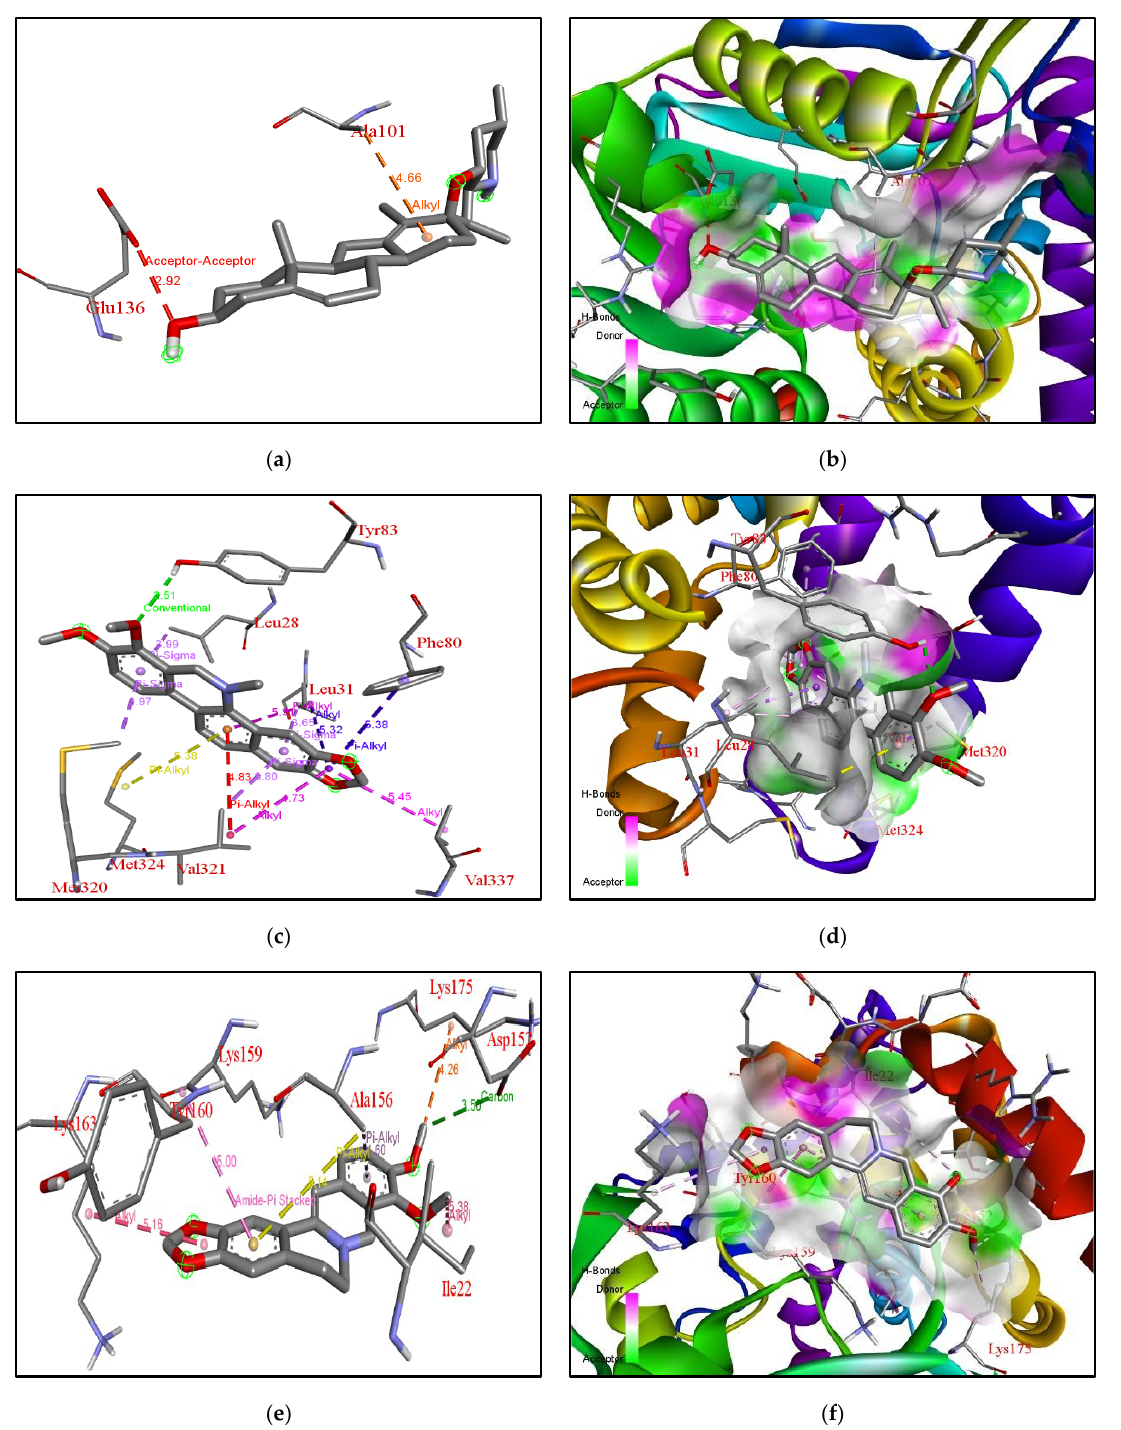
Figure 6. Analysis of docking pocket of ERG6: Interactions, bond lengths and hydrogen bond donor and acceptor around ligand binding pocket for yeast ERG6-ligand interaction are shown in these figures. ( a ) ERG6-cyclopamine acceptor-acceptor interactions in red, alkyl interactions in orange, red. ( b ) ERG6 surface at proximity to cyclopamine. ( c ) ERG6-chelerythrine interactions in red, yellow, magenta, blue, purple, pink, green. ( d ) ERG6 protein surface at proximity to Chelerythrine. ( e ) ERG6 -berberine interactions in brown, yellow, pink, red, orange, green. ( f ) ERG6 surface at proximity to berberine colored pink or green based on hydrogen bond donors or